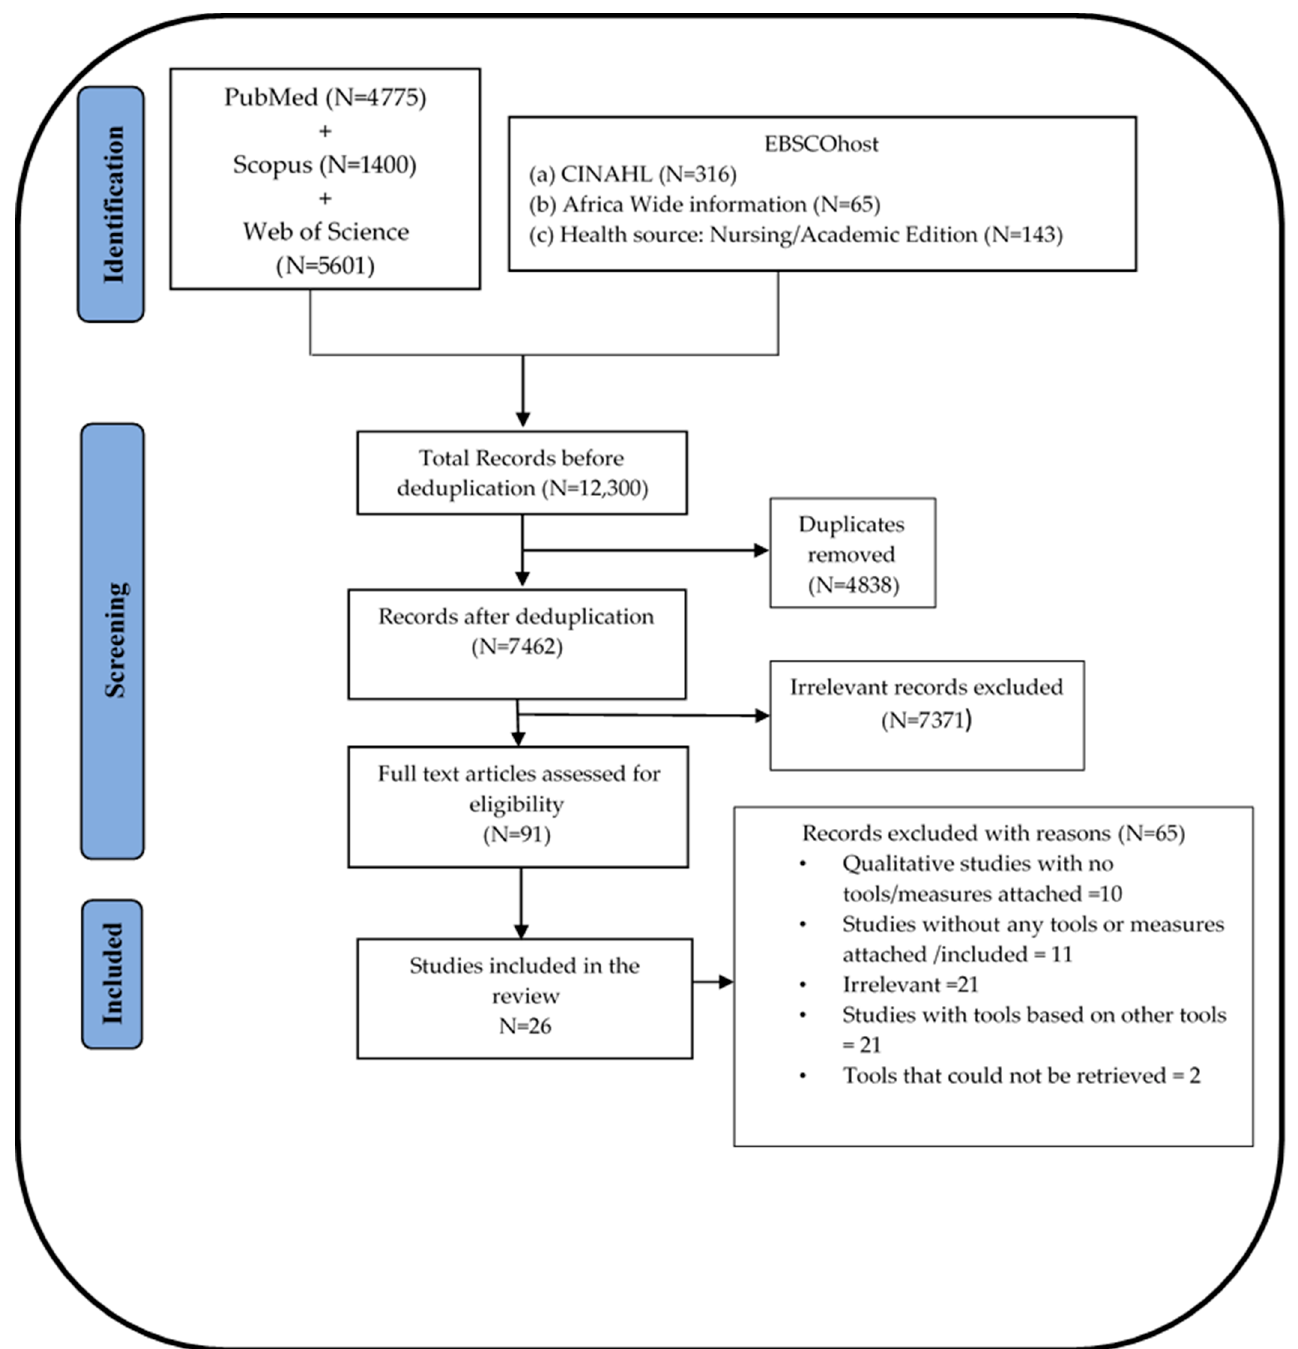
Figure 1. PRISMA flow diagram for the study selection process.